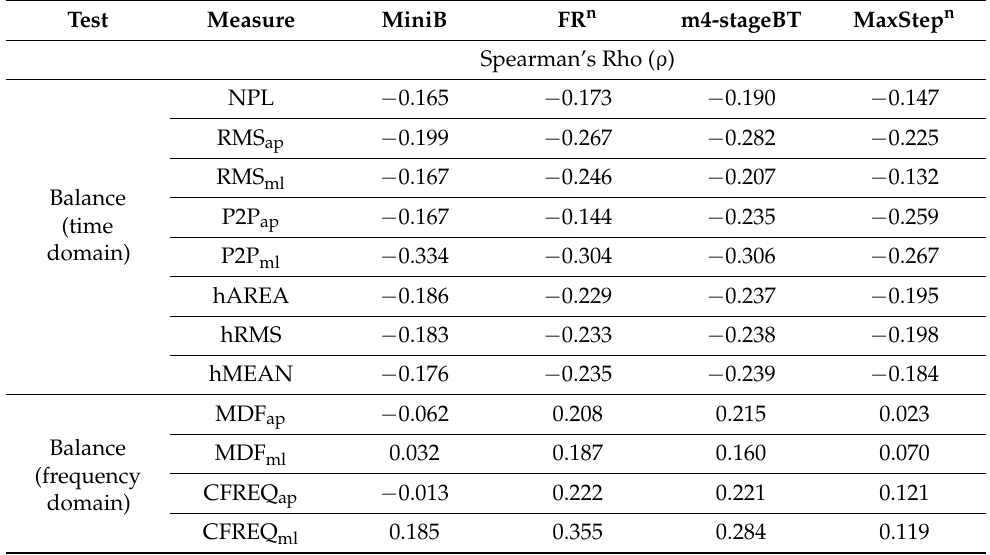
Table 6. Correlation results between clinical balance instruments and sensor-tests for the Semi Tandem Stance (n = 31), using Spearman’s rho ( ρ